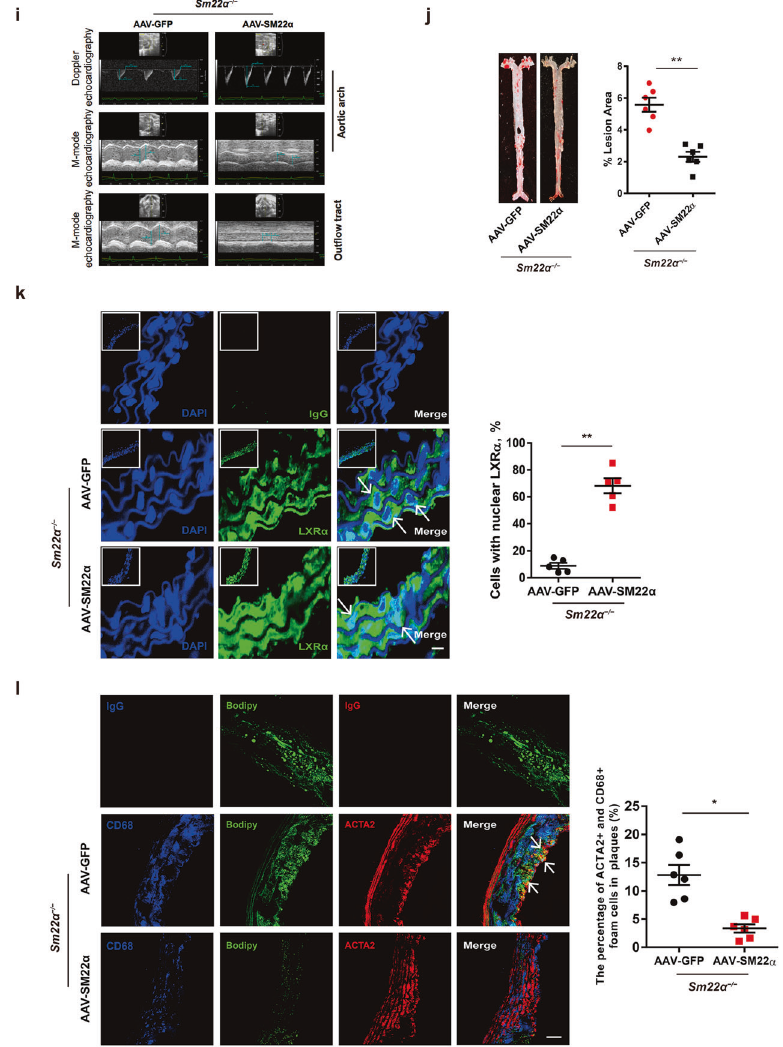
Fig. 3 Function of LXR α -ABCA1 axis is impaired in phenotypically switched VSMCs. a Heatmap of proteomic analysis between synthetic and contractile VSMCs. b Analysis of KEGG pathway enriched by differentially expressed genes of proteomic analysis between synthetic and contractile VSMCs. c The mRNA expression of SM22 α , LXR α , and ABCA1 in WT VSMCs treated with PDGF-BB for 0, 12, 24, and 48 h, respectively ( n = 3). d Confocal microscopy images of LXR α distribution in WT VSMCs incubated with PDGF-BB for 0, 12, 24, and 48 h, respectively. Scale bar, 10 µm. e Confocal microscopy images of LXR α and ACTA2 in arterial walls of WT mice after ligation for 0, 7, 14, and 28 days. Scale bar, 20 µm. f Quanti fi cation of each lipid class in synthetic and contractile VSMCs. Lipid classes were expressed as μ mol per g protein. g Heatmap of CEs between synthetic and contractile VSMCs. h ORO staining of WT VSMCs transducted with or without Ad-GFP-SM22 α following with PDGF-BB and/or cholesterol treatment and quanti fi cation of positive ORO staining. Scale bar, 20 μ m ( n = 3). i M-mode and Doppler echocardiography images obtained from aortic arch and out fl ow tract of Sm22 α − / − mice transducted with AAV-GFP ( n = 10) and AAV-SM22 α ( n = 10) fed Paigen diet for 12 weeks. A s : out fl ow tract and aortic diameter in systole; A d : out fl ow tract and aortic diameter in diastole. j Representative images of en face ORO-stained aortas and quanti fi cation of lesion areas ( n = 6). k Representative immuno fl uorescence of LXR α (green) and quanti fi cation of cells with nuclear LXR α in the aortic sections from Sm22 α − / − mice transducted with AAV-GFP ( n = 4) and AAV-SM22 α ( n = 4) fed Paigen diet for 24 weeks. Scale bar, 10 µm. Arrows indicated the distribution of LXR α . l Identi fi cation of SMC-derived foam cells within atherosclerotic lesion of Sm22 α − / − mice infected with AAV-GFP ( n = 4) and AAV-SM22 α ( n = 4) fed Paigen diet for 24 weeks by CD68 (blue), ACTA2 (red), and Bodipy (green). Scale bar, 25 µm. Arrows indicated foam cells which were VSMCs-derived. Data and images are representative of at least three independent experiments. Data in c were analyzed by two-way ANOVA. Data in f , h , j , k , and l were analyzed by unpaired t -test. * p < 0.05; ** p < 0.01; *** p < 0.001; **** p < 0.0001.